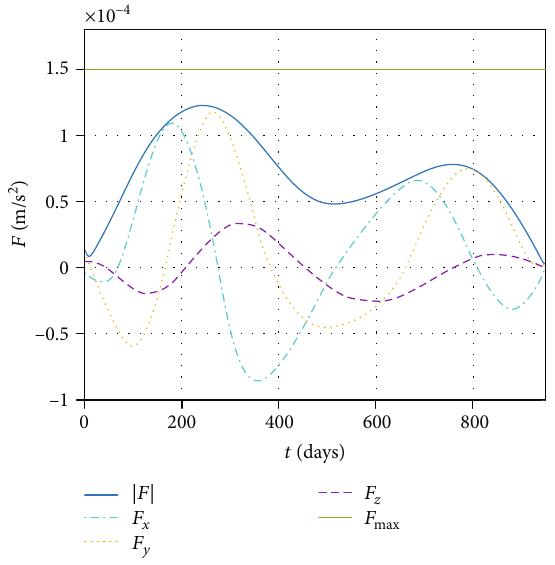
Figure 6: Trajectory acceleration pro fi le with the least fuel requirement.